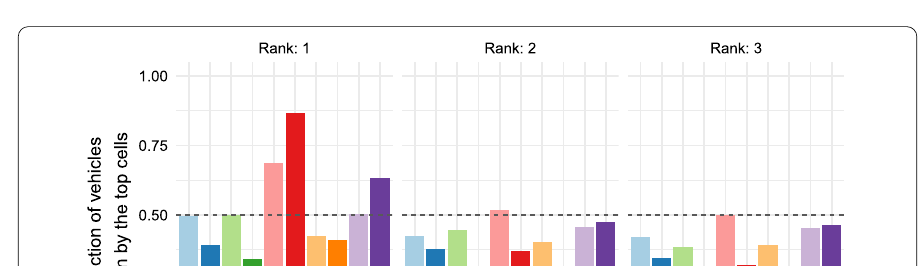
cells in each cities, i.e., the three cells that see the highest number of distinct vehicles dur- ing two different time windows ( W = 30 and W = 15 days, respectively). Assuming that a (somewhat generous) threshold of 50 % vehicles would be acceptable for the car sharing operator to justify the opening of a workshop in the area, all cities with the exception of Florence would accomodate three workshops satisfying this requirement when W =